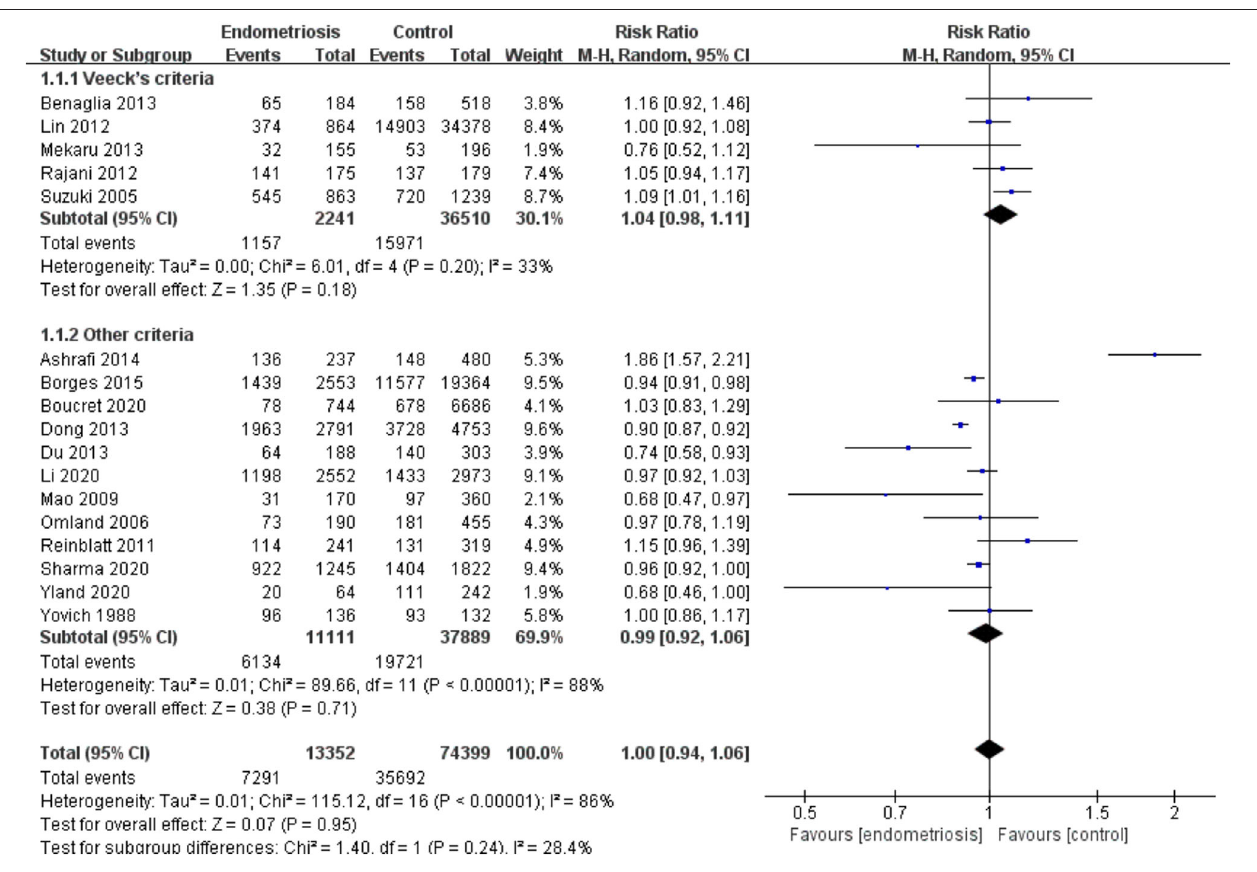
FIGURE 2 | Forest plot of high-quality embryo rate for endometriosis vs.